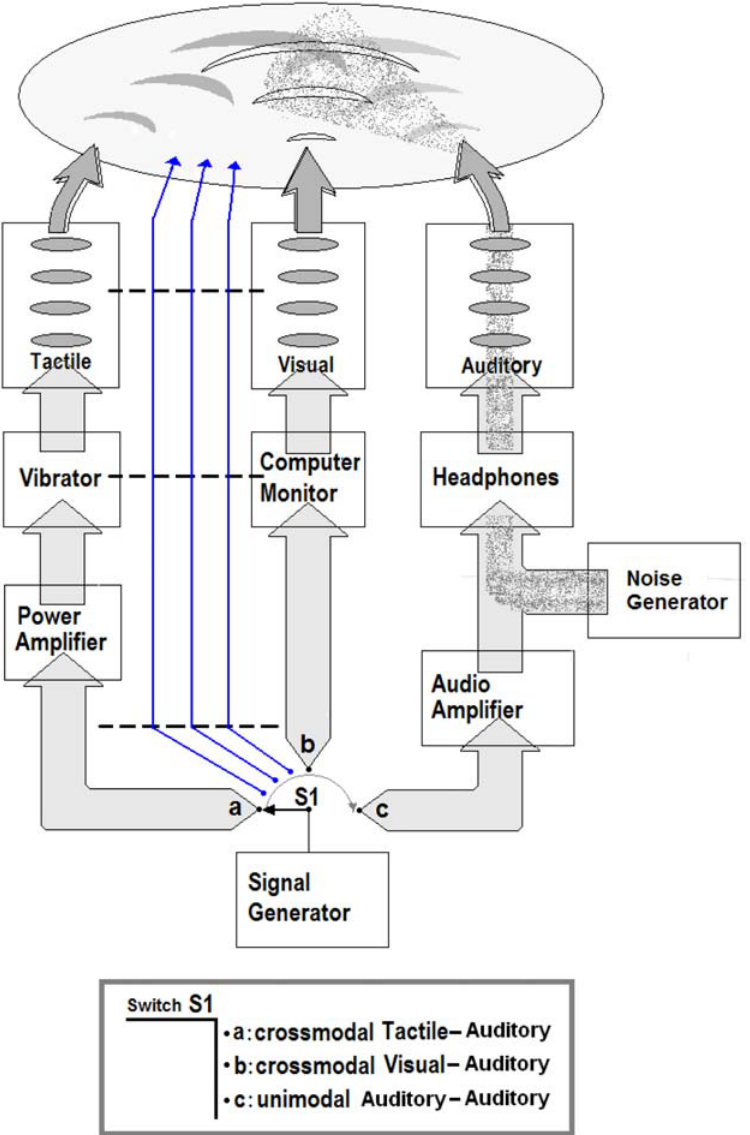
Figure 8. Unimodal and crossmodal SR architecture. The scheme represents the physical paths through which the signals combine in the brain.